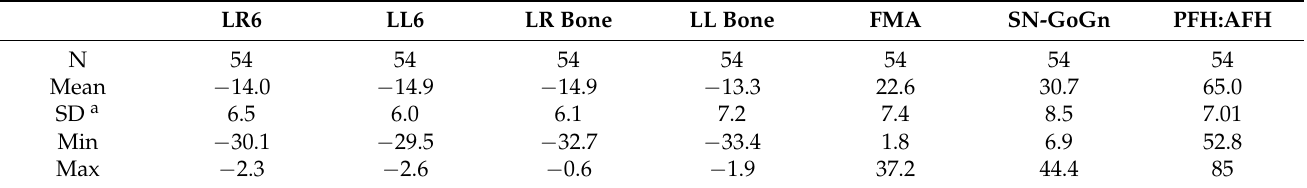
Table 1. The measurements of inclinations of lower first molars and their alveolar bones, and verti- cal cephalometric measurements.